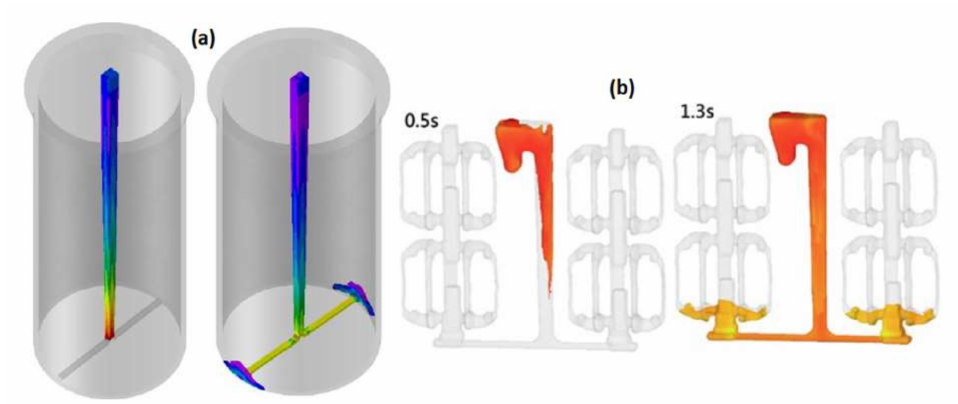
Figure 8. Flow in hyperbolically tapered sprues without free surface after the first portion of the liquid alloy for sleeve casting ( a ) [26] and support bracket ( b ) [27]